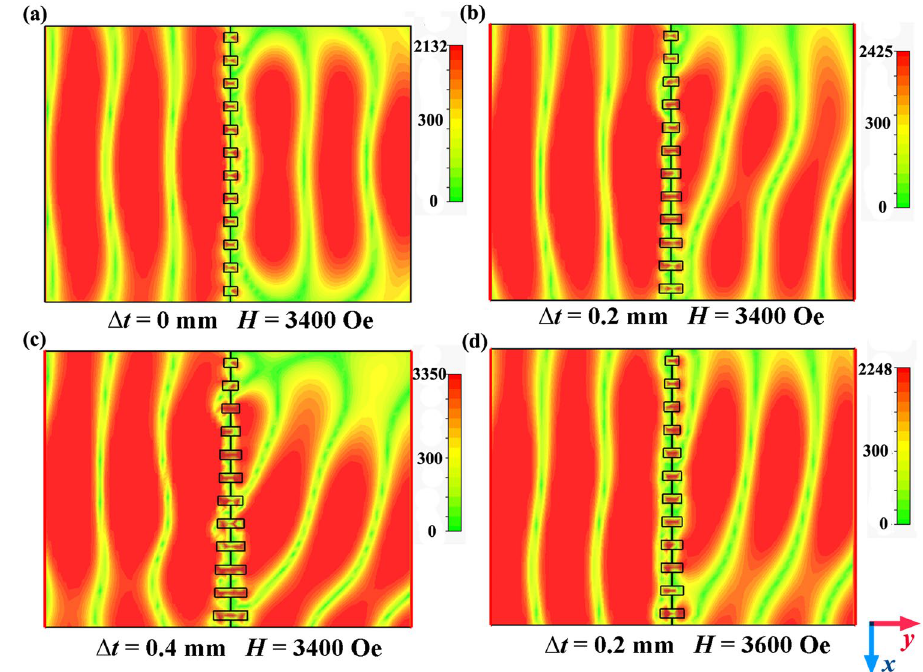
Figure 5. Simulated electric field distributions in the xy -plane for a plane wave propagated through the metasurfaces. ( a ) Sample 1 with H = 3400 Oe. ( b ) Sample 2 with H = 3400 Oe. ( c ) Sample 3 with H = 3400 Oe. ( d ) Sample 2 with H = 3600